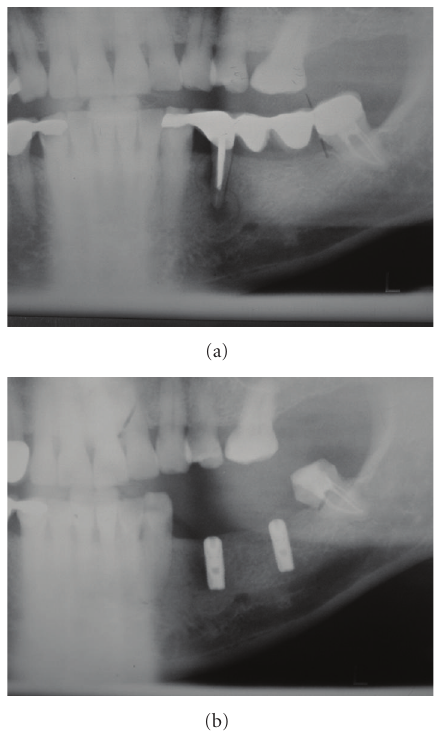
Figure 1: (a) Panoramic radiograph revealing periapical radiolu- cency in endodontically treated left mandibular premolar, when pa- tient was completely healthy (March 2006). (b) Panoramic radio- graph showing dental implants before final restoration. Implants were completely osseointegrated, and no mandibular lesions were observed (September